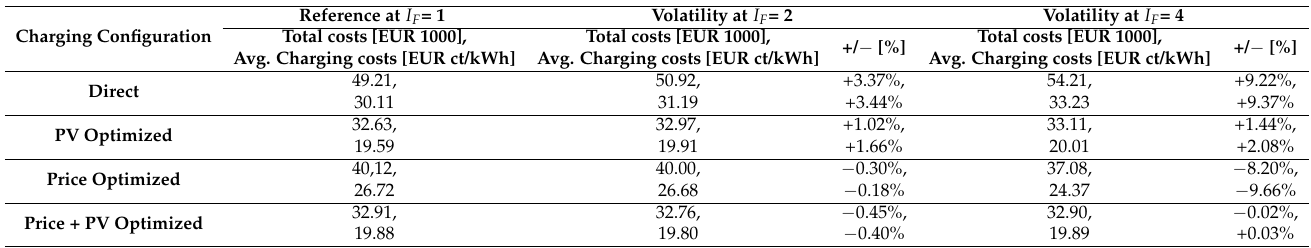
Table 4. Economical aspects while considering different incremental